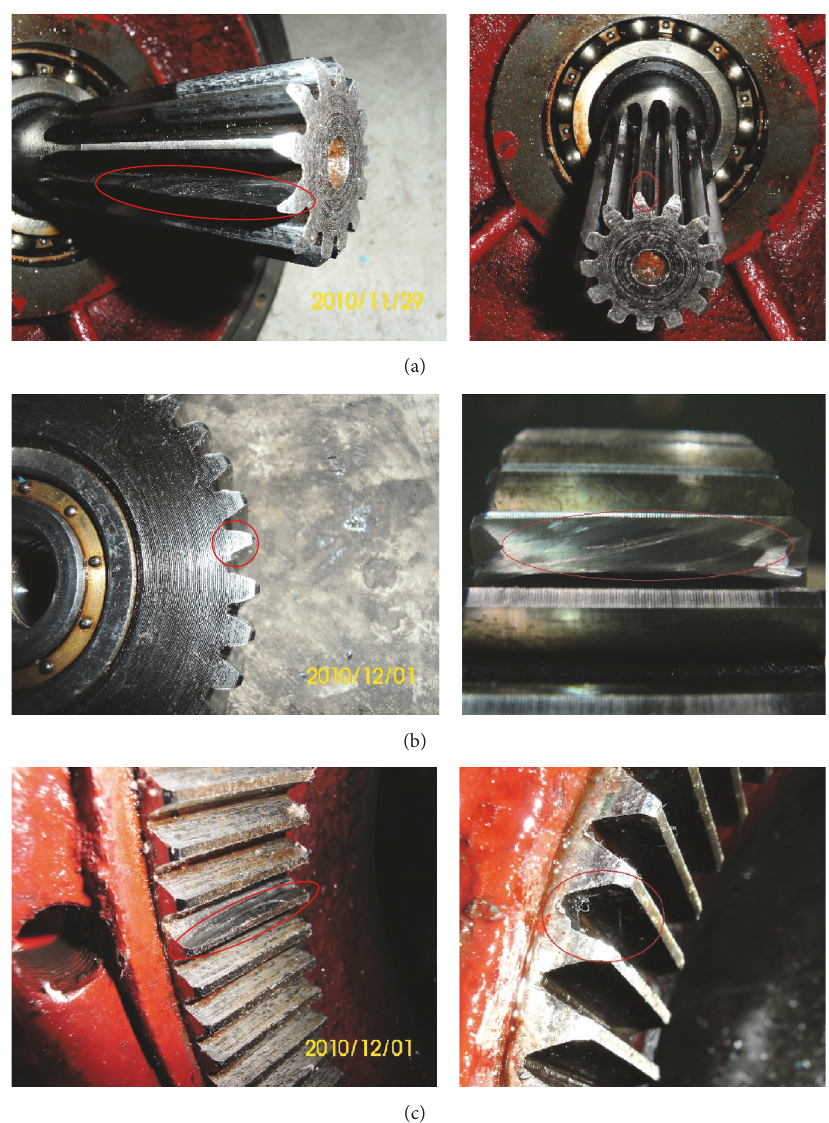
Figure 7: Localized fault on (a) sun, (b) planet, and (c) ring